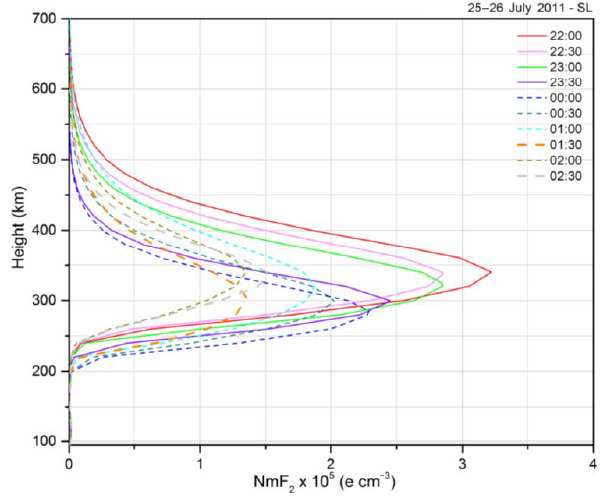
Figure 9. F-layer plasma density profile for 25–26 July derived from digisonde data and SAO Explorer data for several hours